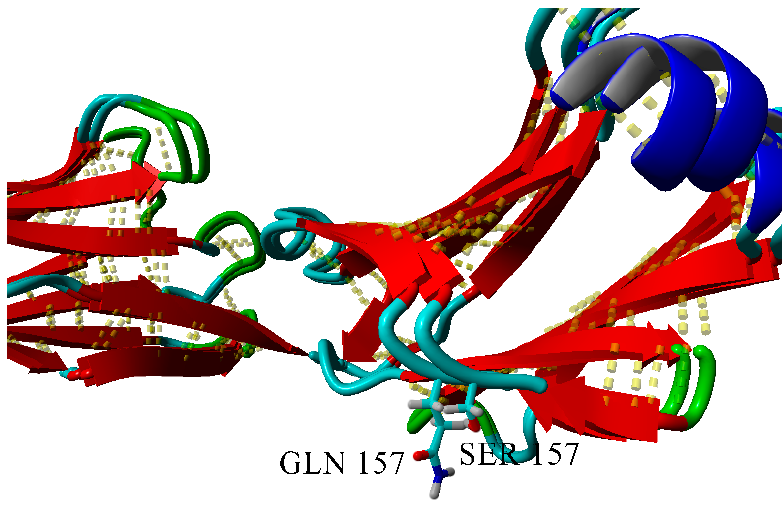
Figure 13. Superposition of wild-type and S157Q variants of BIF.